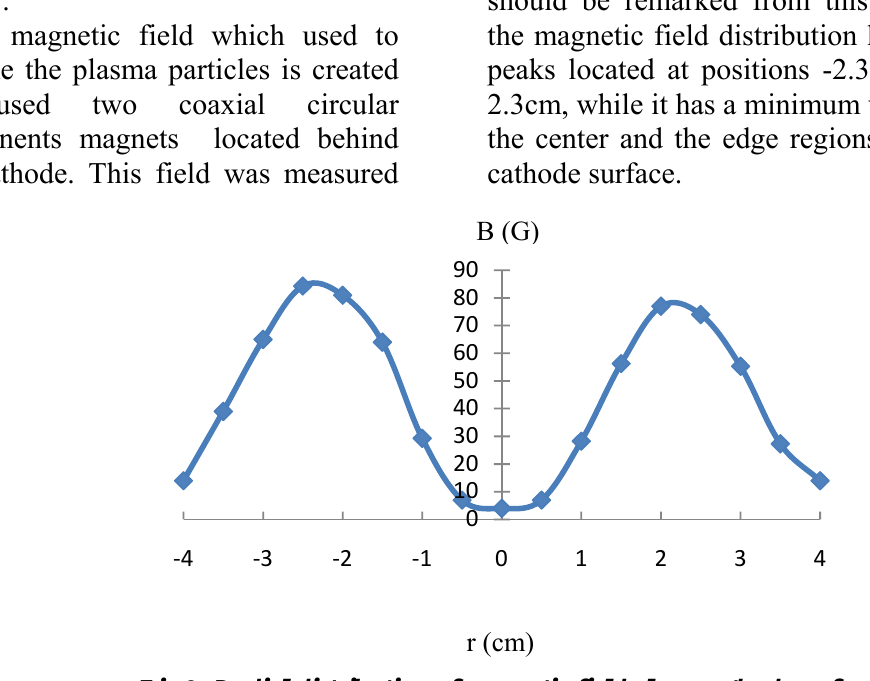
Fig.2: Radial distribution of magnetic field along